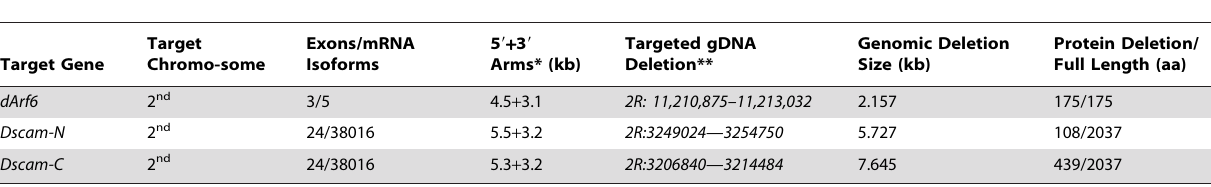
Table 1. Design of gene targeting for dArf6 , Dscam-N and Dscam-C founder Knock-out lines.